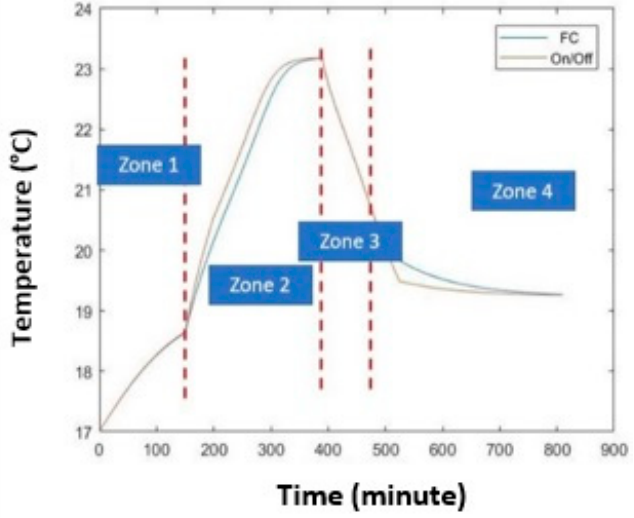
Figure 13. Temperature evolution in a theoretical classroom with a medium size by using a FC and On/Off controller. Zone: It remarks different conditions during the experiments.